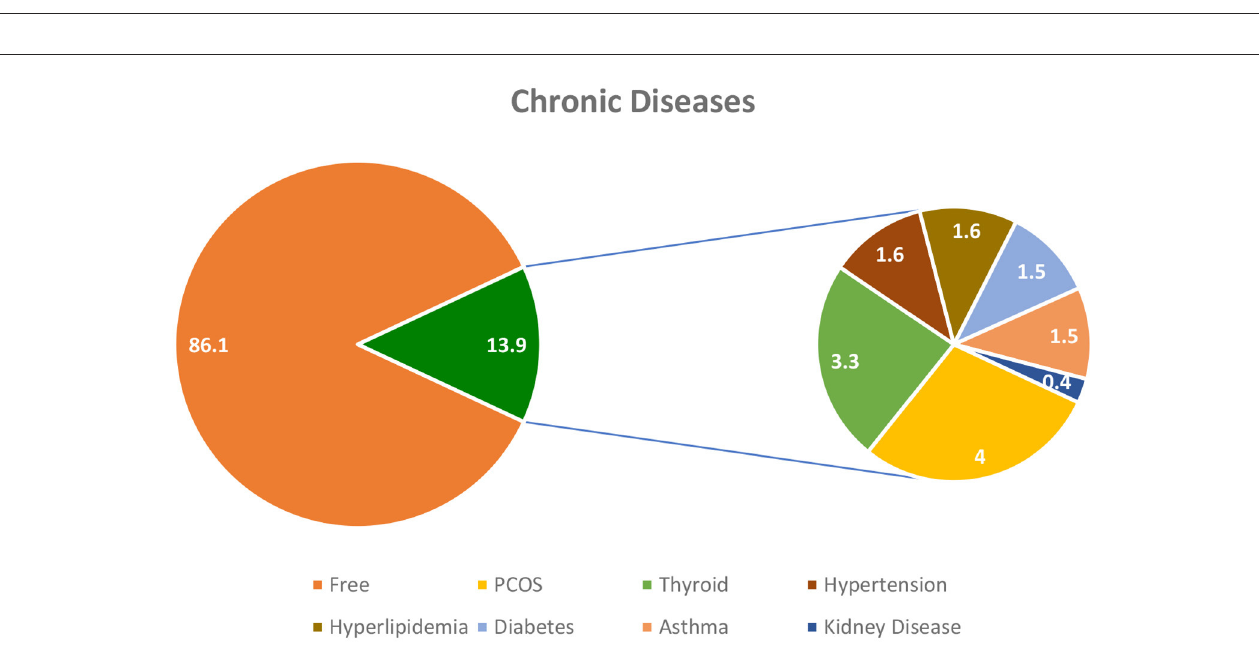
FIGURE3 Chronic disease distribution among the study participants.